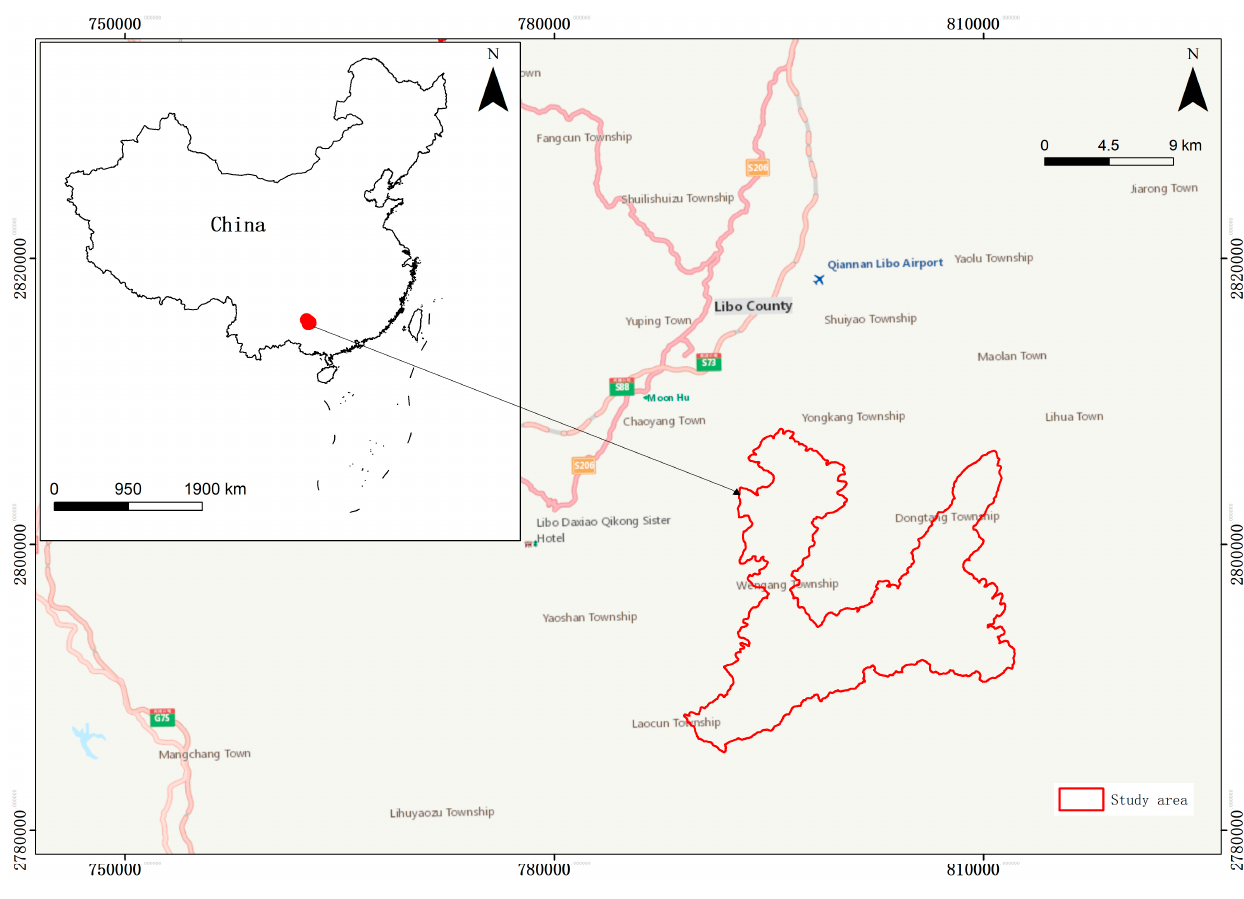
Figure 1. Location of study area in Southwest China.